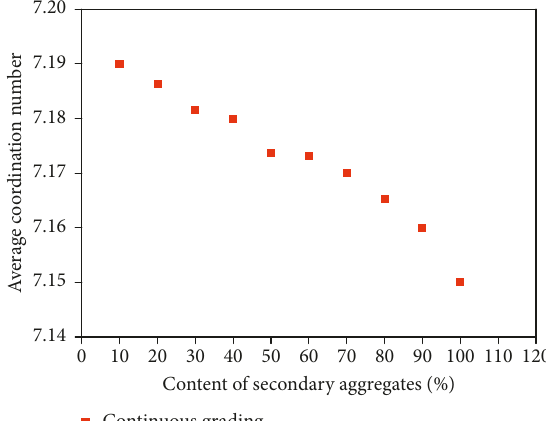
Figure 15: Variation of the initial average coordination number with the content of secondary